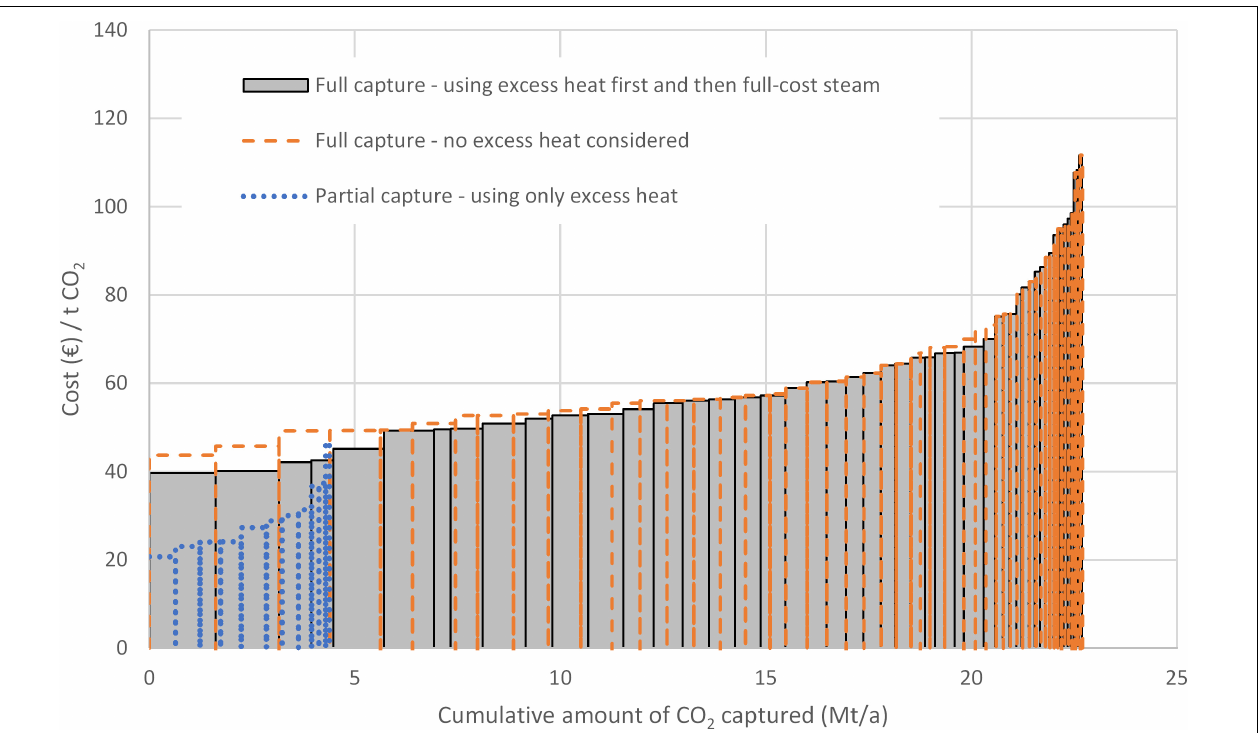
FIGURE 2 | Effect of excess heat on capture costs for Swedish emission sources > 500 kt CO 2 /a. The black dotted line is the same as in Figure 1 . The red dashed line represents 90% capture of total site emissions using only full-cost steam. The blue line represents partial capture of the CO 2 that can be captured by means of 1 MJ of excess heat per kg CO 2 emitted at a given